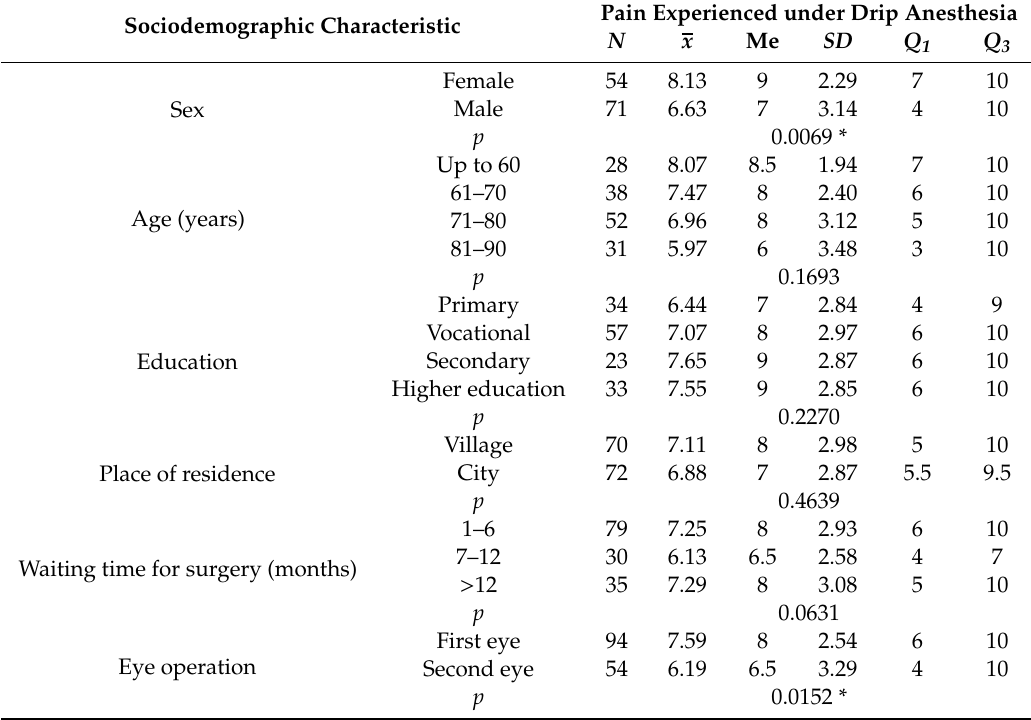
Table 7. E ff ect of selected sociodemographic characteristics on the occurrence of pain with the use of intravenous drip